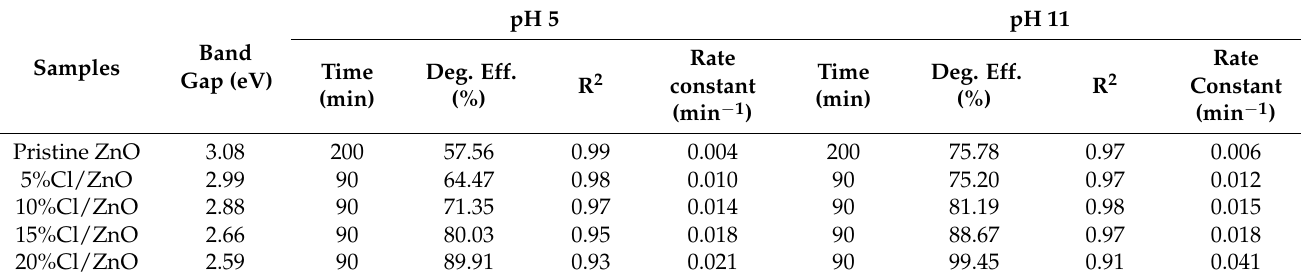
Table 2. Time for degradation, degradation efficiency, R 2 and rate constant at pH 5 and